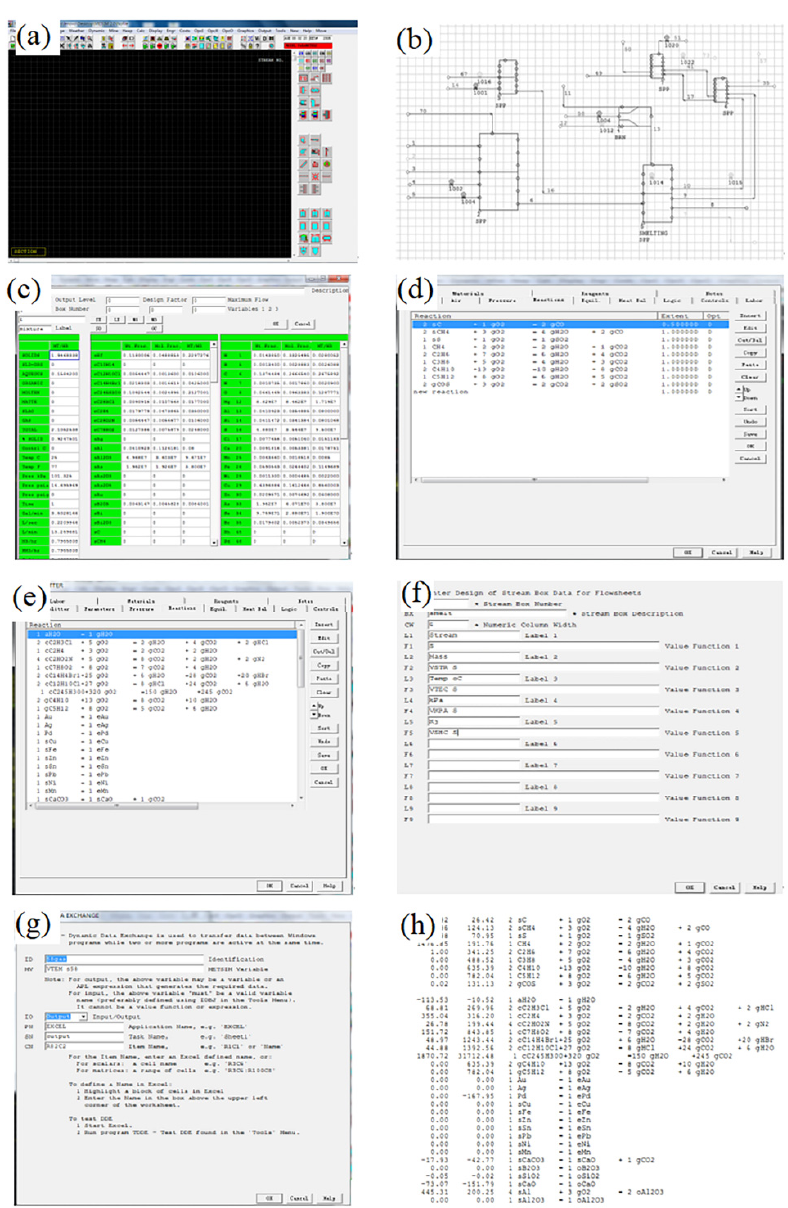
Figure A1. The calculation process of the MESTSIM simulation. ( a ) The main interface of METSIM, ( b ) the built-in NRT process in the software, ( c ) the input of raw materials in the calculation, ( d ) the definition of chemical reactions, ( e ) the setting of the progress of different reactions, ( f ) the setting of units of output parameters, ( g ) the definition of the displaying interface, and ( h ) the obtained energy